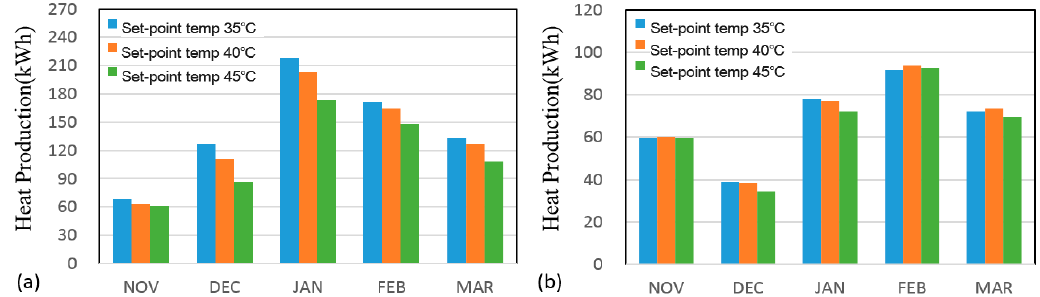
Figure 31. Heat production in PVT module ( a ) for building heating ( b ) for heat storage according to Change of solar heating temperature.